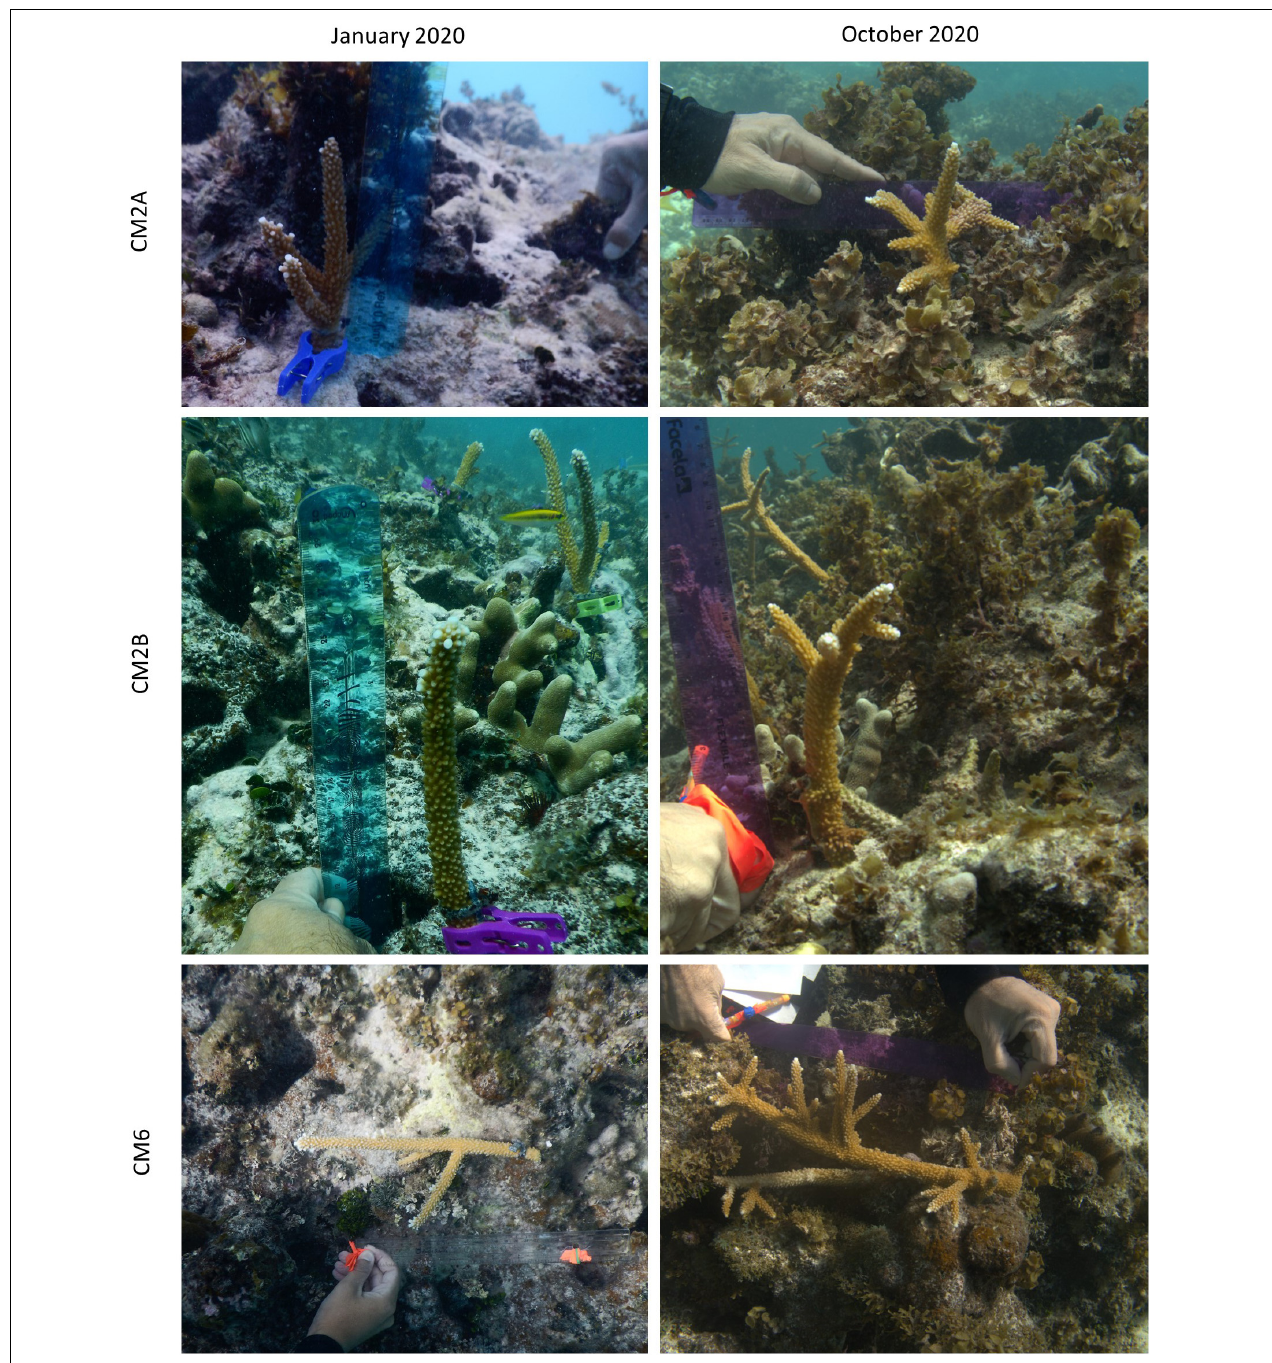
FIGURE 4 | Coral monitoring photos comparing growth of outplants between January 2020 and October 2020.